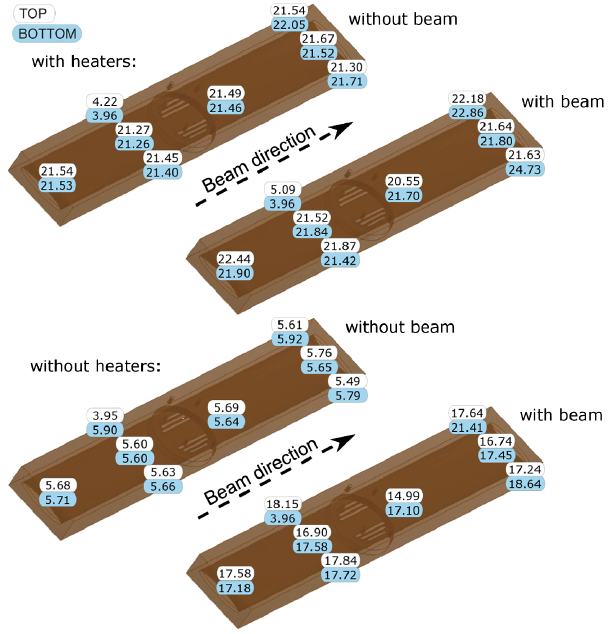
FIG. 12. The temperature distribution on the cold liner without beam and with a stored electron beam with 300 mA and 685 bunches, while keeping the cooling connection from the cry- ocooler to the liner at 20 K powering the heaters on the liner itself (upper plot), and without using the heaters (lower plot).